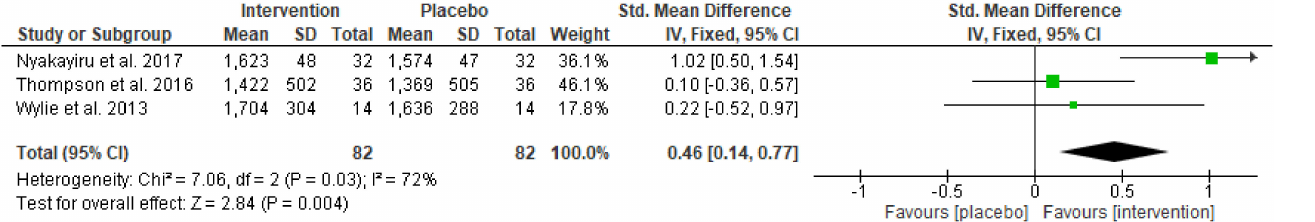
Figure 6. Forest plot comparing the effect of beetroot supplementation on the distance covered in Yo-Yo IR1